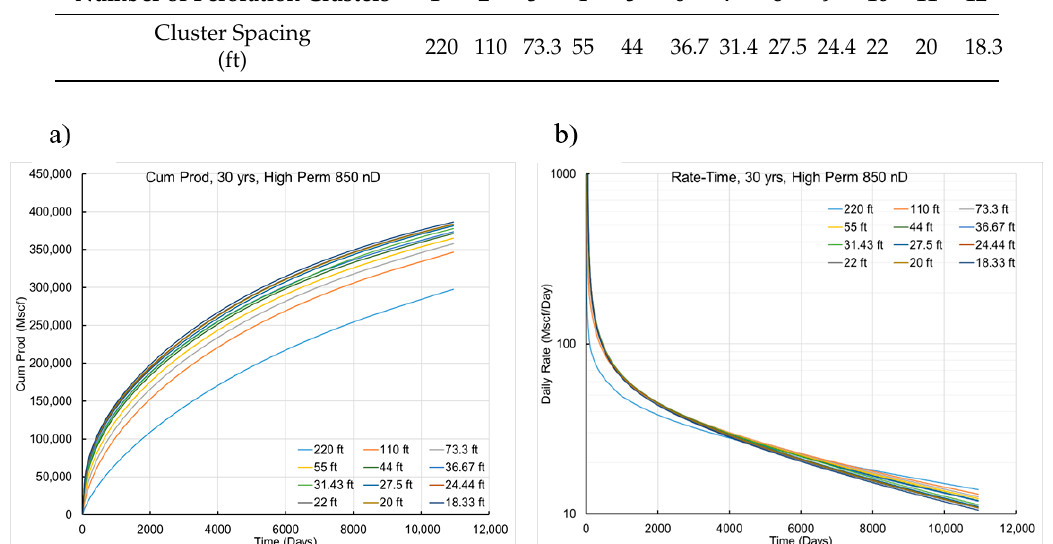
Figure 3. Well performance curves were generated for Utica wells with a numerical reservoir simulator by ResFrac for fracture spacing ranging between 220 and 18.3 ft (Table 1). The base case performance is for the Utica type well with 55 ft fracture spacing. The impact of wider and narrower fracture spacing on well productivity is graphed for both ( a ) the cumulative, and ( b ) daily production rates (data from Reference [13]).